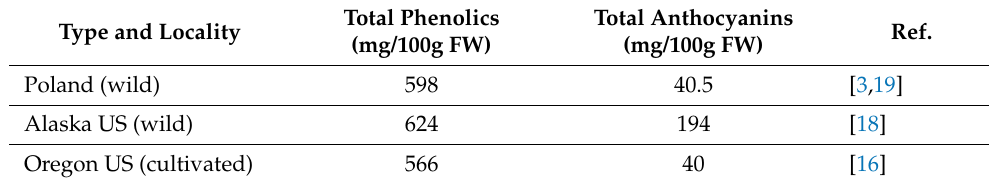
Table 1. Mean total phenolics and monomeric anthocyanins content in wild and cultivated lingonberries. Type and